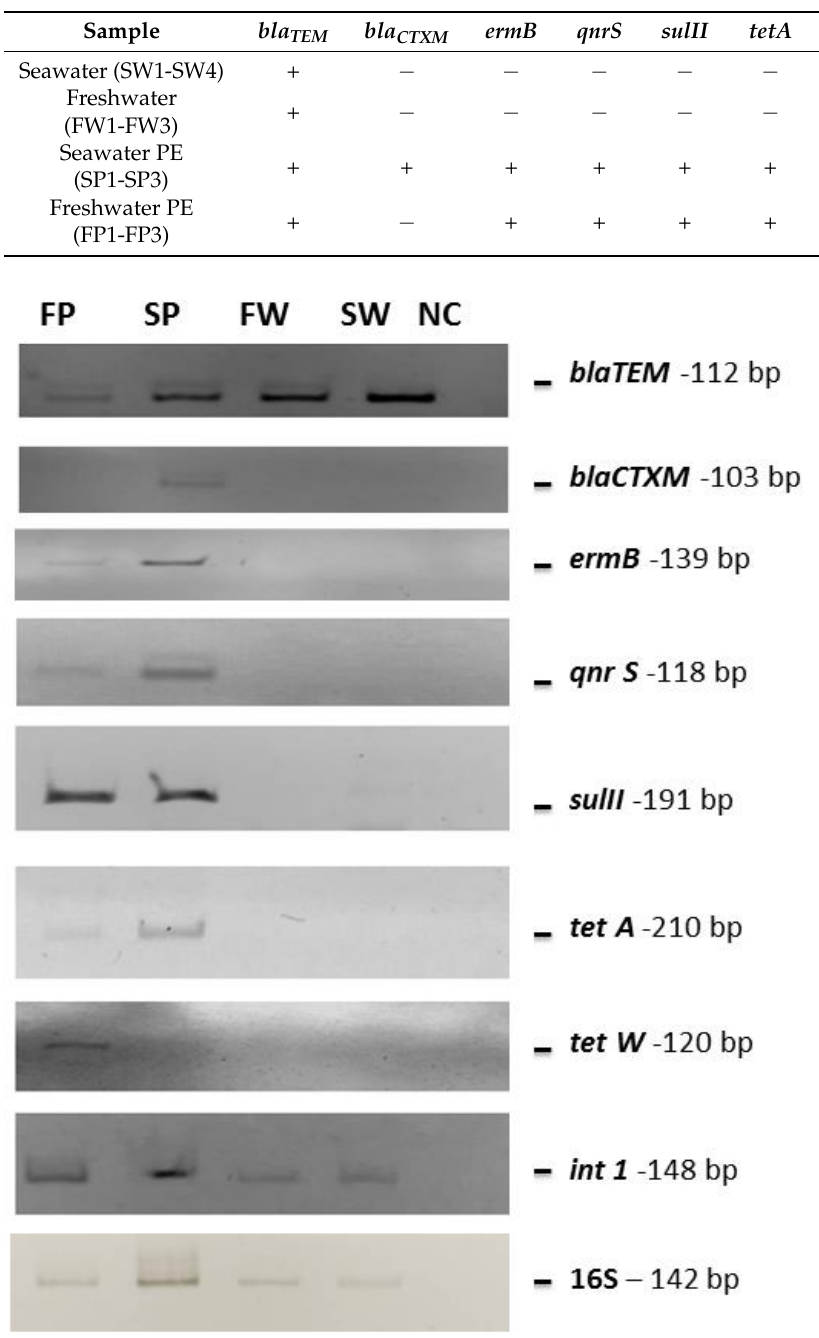
Figure 4. PCR gels showing the obtained amplified bands. The same quantity of pooled DNA (10 ng) as the template was used in each reaction. SW, FW, SP, and FP stand for seawater, freshwater, seawater PE, and freshwater PE, respectively. NC indicates the negative control (water instead of DNA as template).